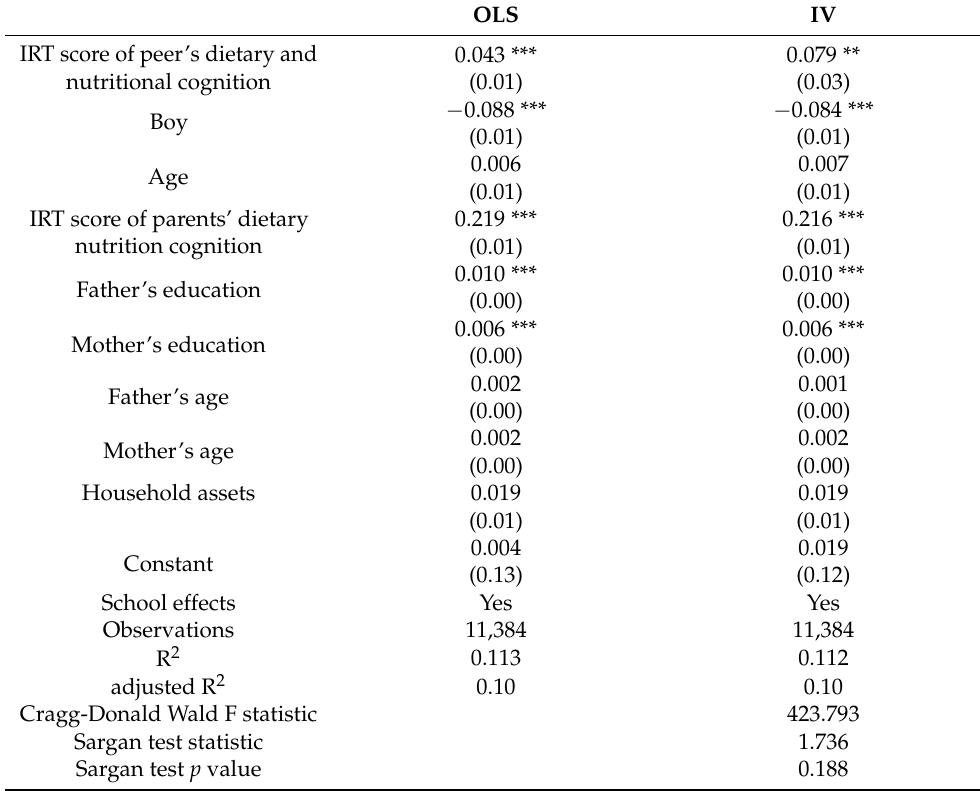
Table 4. Robustness